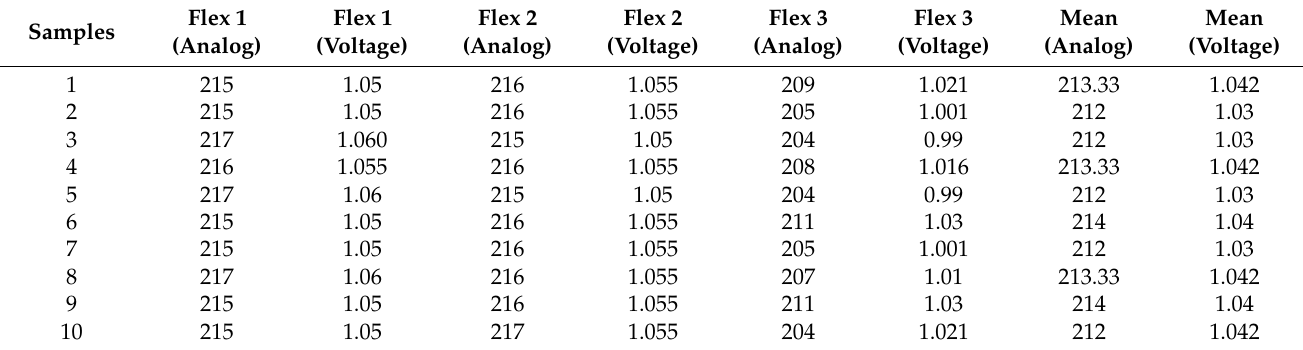
Table 4. The output of three flex sensors in analog and voltage with mean (Age group: 18–25 years, temperature 34 ◦ C to 41 ◦ C, June